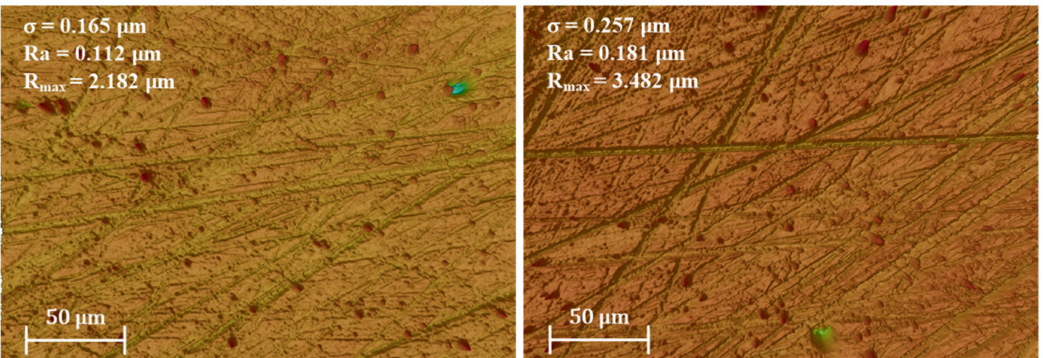
Figure 4. The two measured surface topographies with di ff erent roughness.